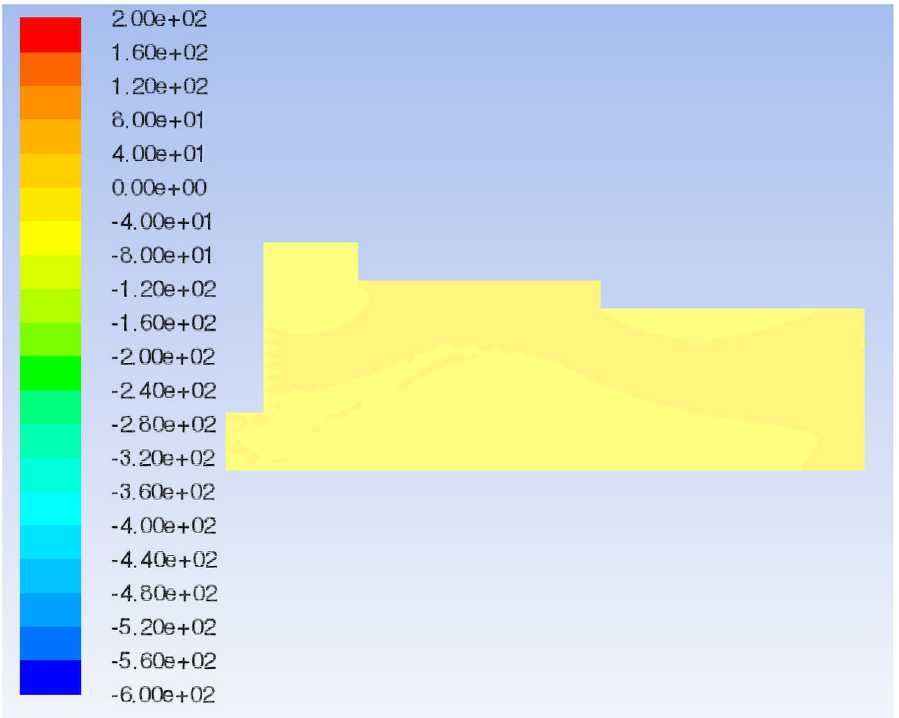
Fig 13. Flow field total pressure distribution of the increased air volume